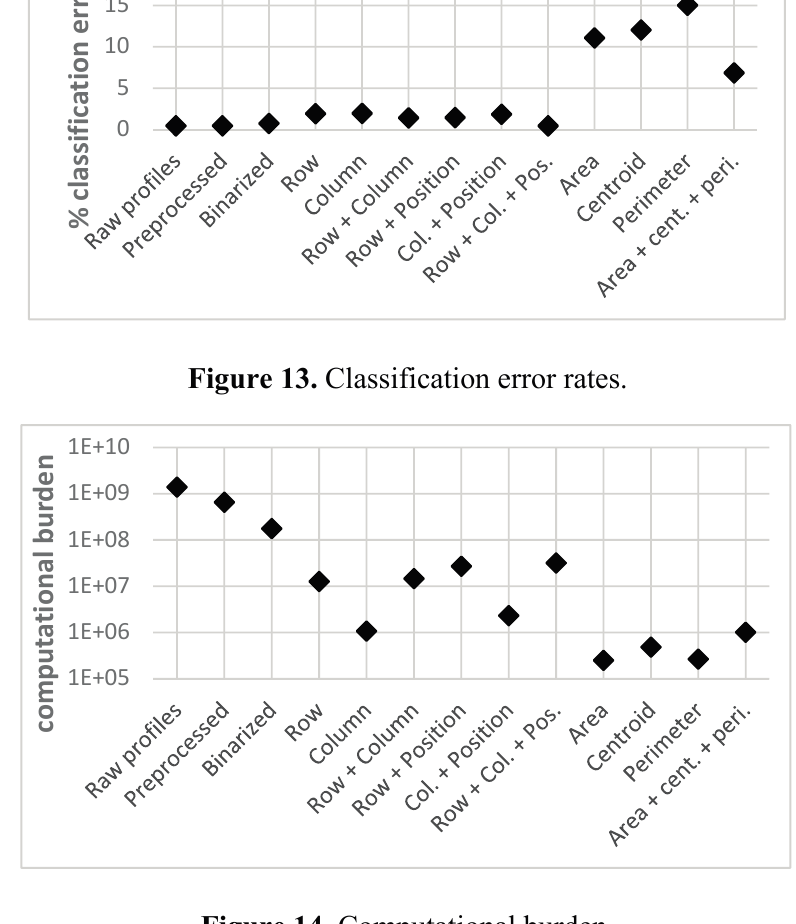
Figure 14. Computational